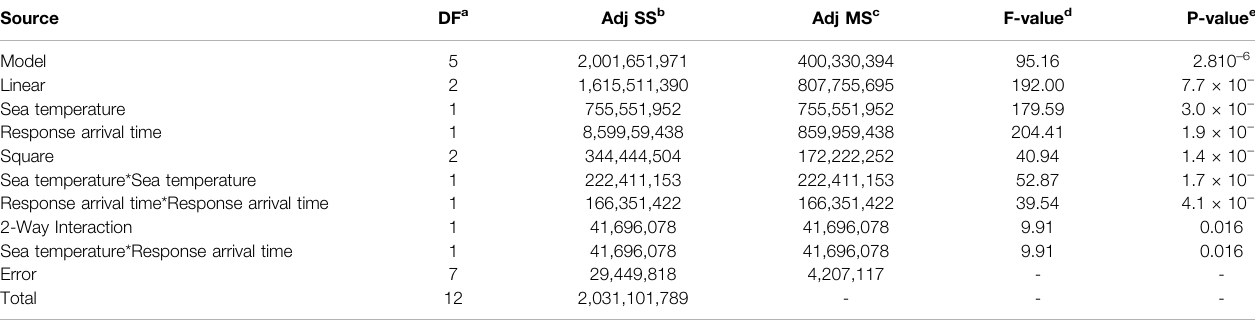
a “ DF ” represents the degree of freedom. b “ Adj SS ” means the adjusted sum of squares, illustrating the amount of variation explained by each component in the model. c “ Adj MS ” as the adjusted mean of squares is computed by dividing the “ Adj SS ” by “ DF ” . d “ F-Value ” is the model statistic. e “ p -Value ” is a statistical measurement used to validate the signi fi cance of results based on the typical signi fi cance level (0.05).